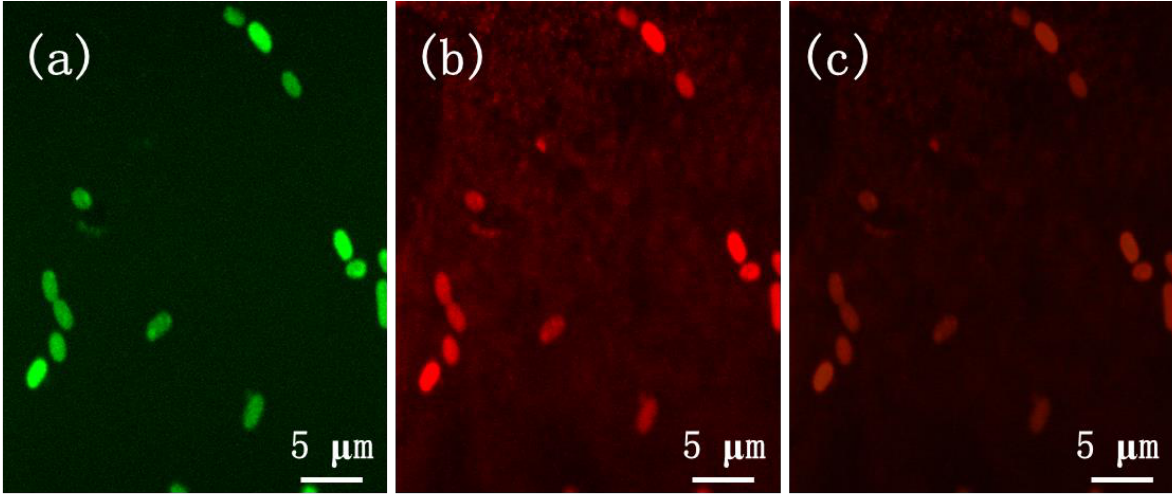
Figure 6. CLSM image of E. coli . ( a ) Green fluorescence from CQDs, ( b ) the fluorescence of Dil dye, ( c ) composite image of ( a , b ) [CQDs] = 500 μg/mL.